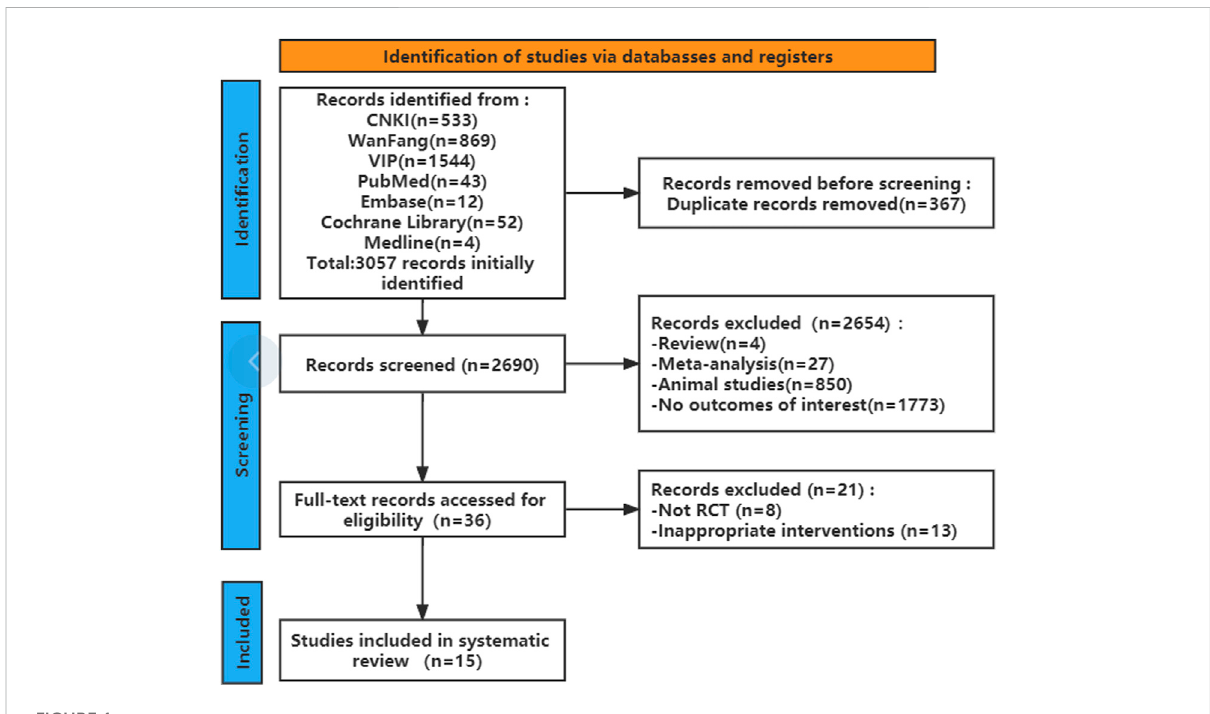
FIGURE 1 Study selection process for the systematic